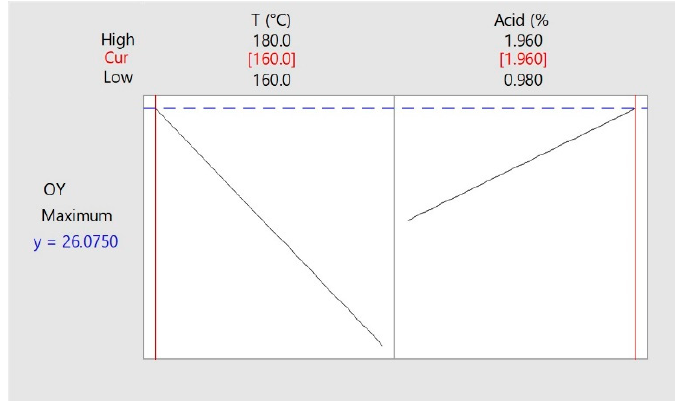
Figure 4. The optimization plot shows the conditions needed to maximize the OY. The vertical red lines on the graph represent the current factors’ (temperature and acid concentration) settings.